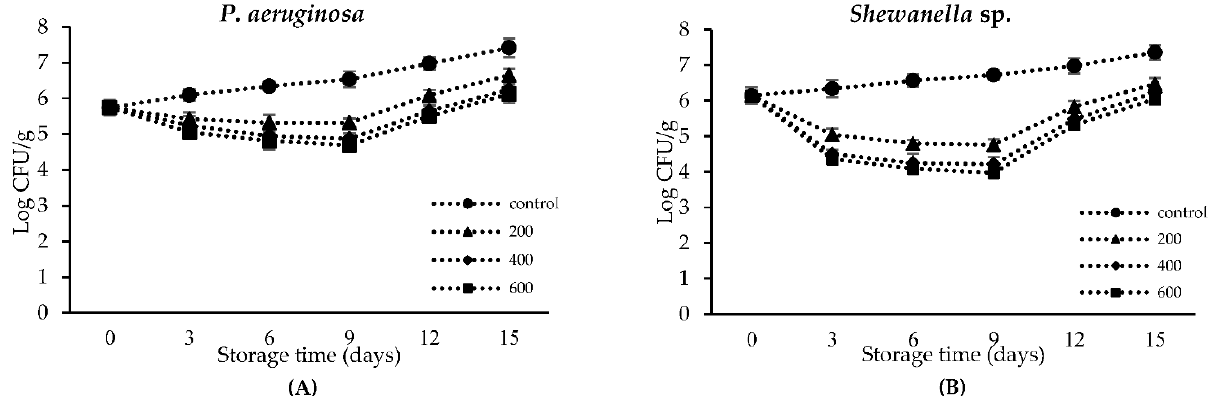
Figure 6. Effectiveness of CLE at different concentrations (200, 400, and 600 ppm) against P. aeruginosa ( A ) and Shewanella sp. ( B ) counts in tilapia slices during refrigerated storage. Challenge test was used in this study. Bars represent the standard deviation ( n = 3).